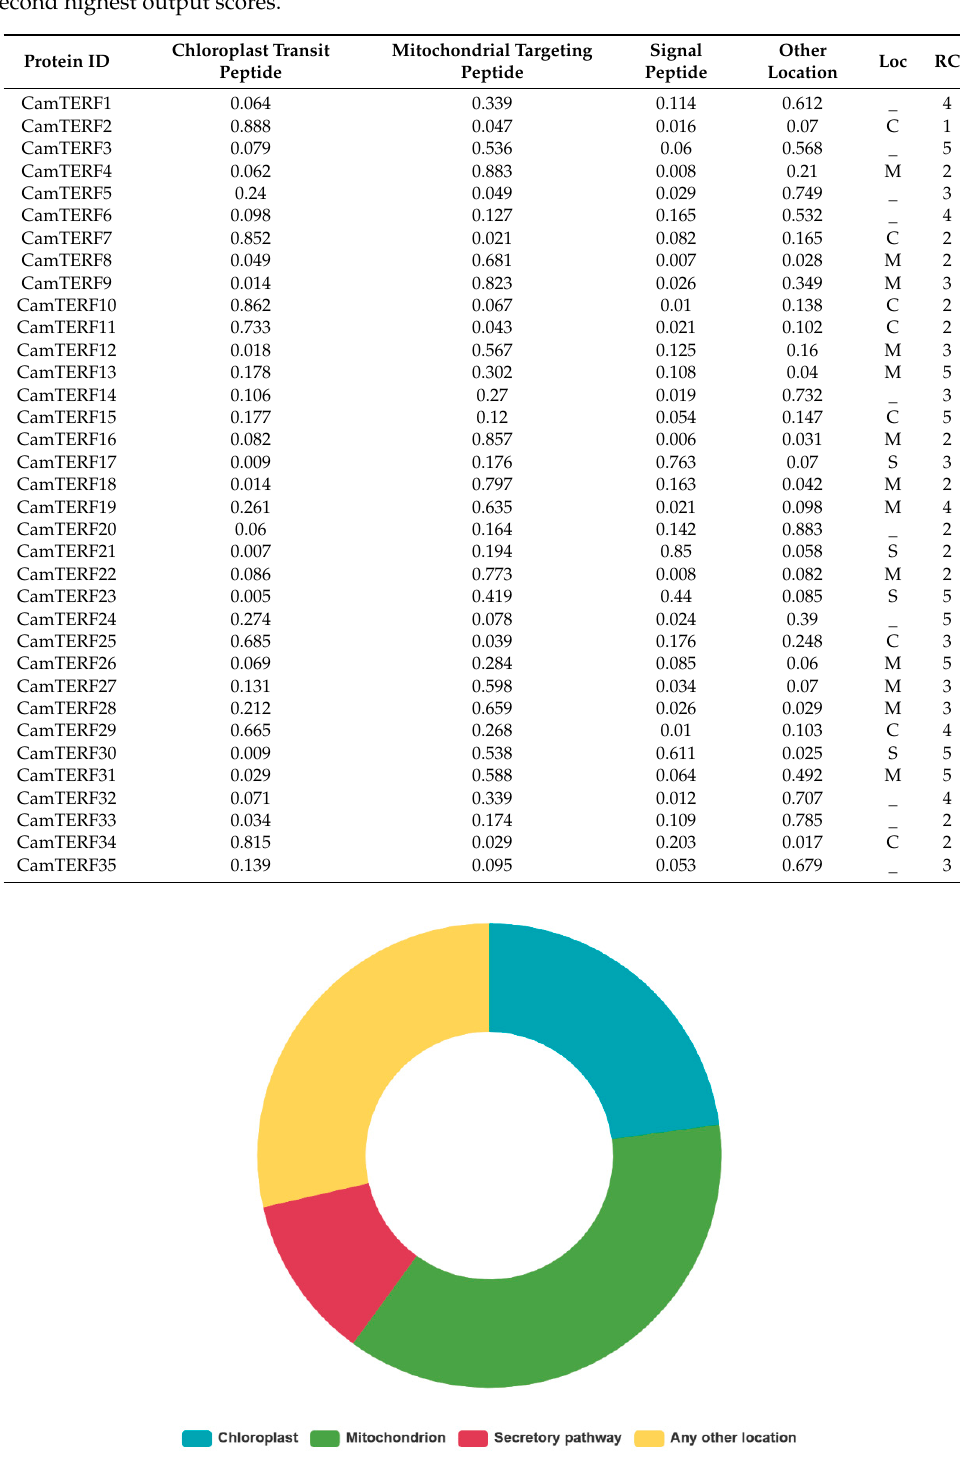
Figure 2. CamTERFs protein predicted of the Subcellular localization. Table 2. Subcellular localization of CamTERFs. Listed are the predicted protein output scores for chloroplast transit peptide (C), mitochondrial targeting peptide (M), signal peptide (S), or any other location (-). Location (Loc) details the subcellular localization predicted based on the prediction scores and reliability class (RC, 1 – 5) indicates the strength of the prediction, with 1 indicating the strongest prediction. RC is a measure of the size of the difference (‘diff’) between the highest (winning) and the second highest output scores. Protein ID M